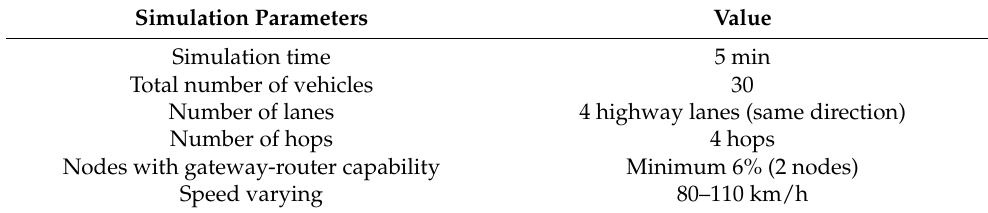
Table 1. Simulation parameters.